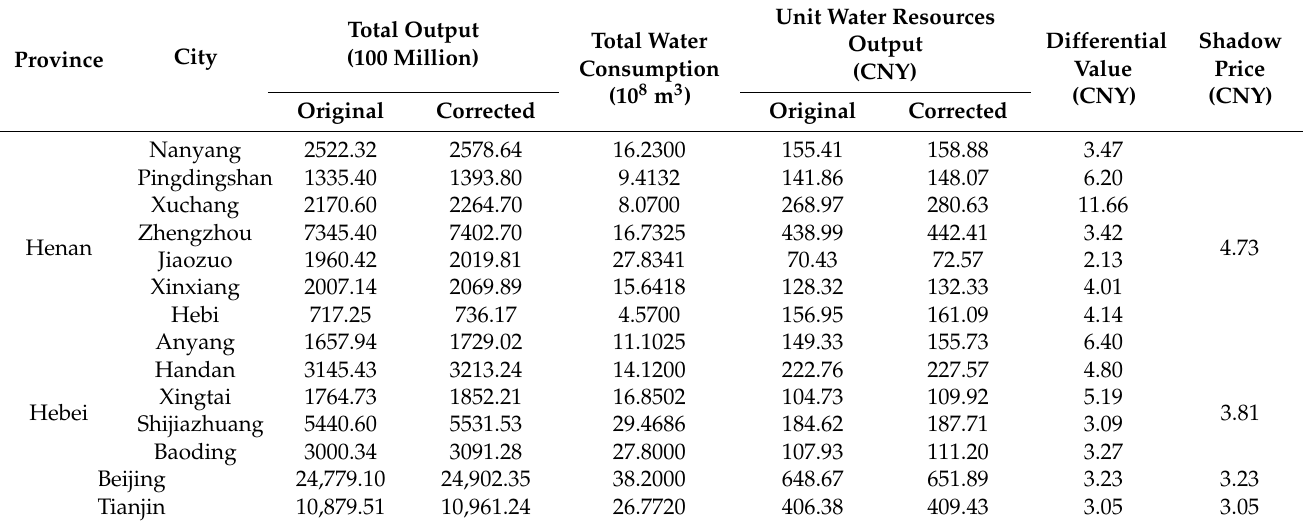
Table 7. Optimization results for the total sectoral output of receiver areas in